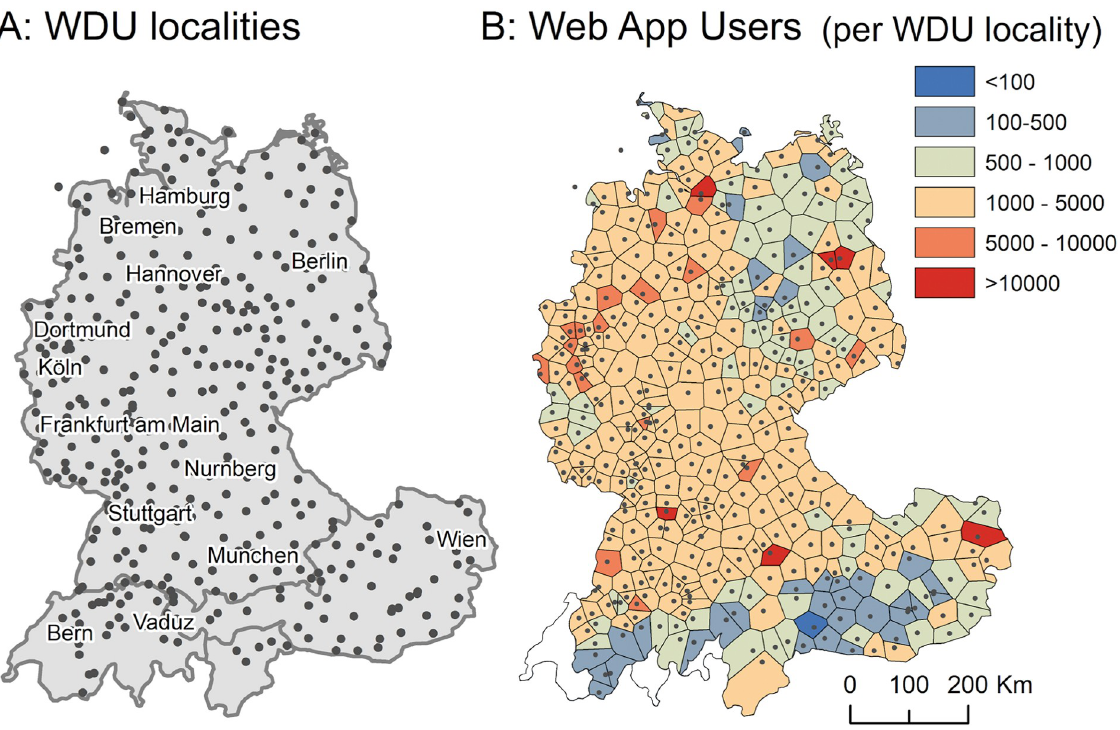
Fig 3. Distribution of localities in the historic WDU survey (A) and contemporary data (B). Counts of localities in the contemporary data are aggregated for each WDU locality.